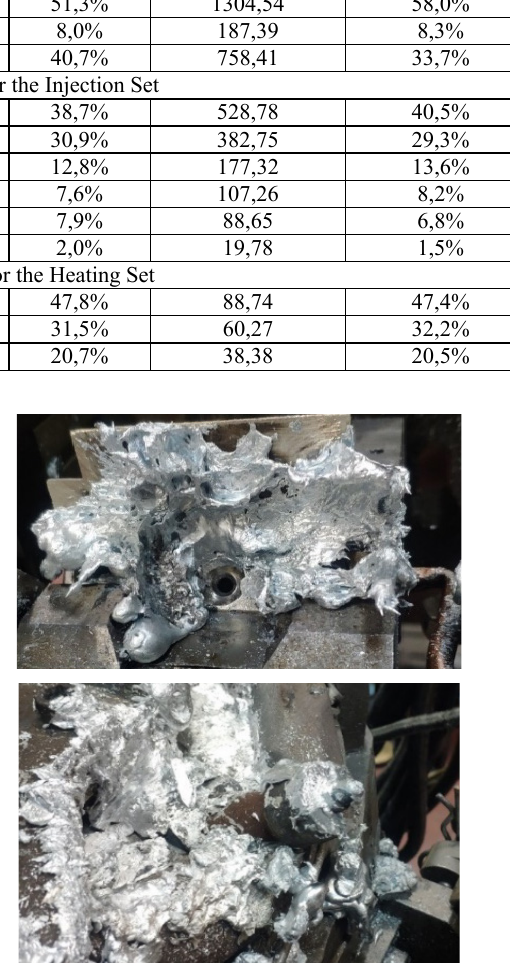
Figure 5. Injection failure caused by technical problems on the coupling system elements.